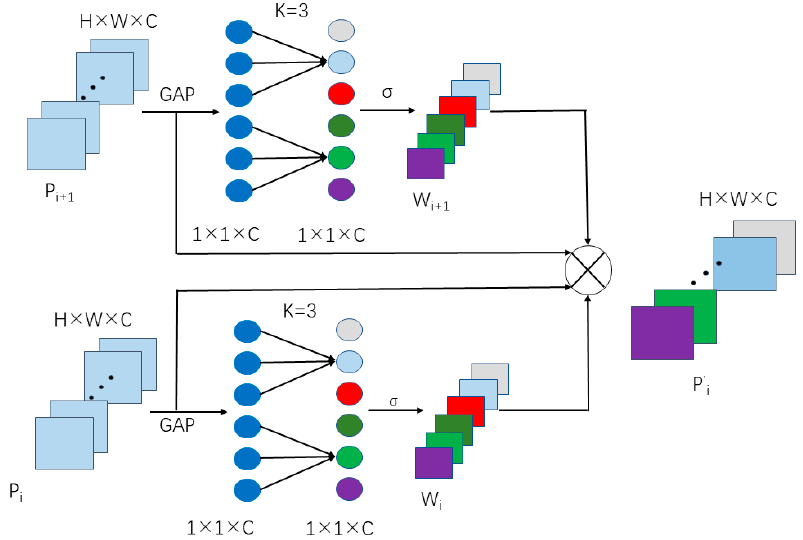
Figure 5. ECA-based weighted feature fusion module.